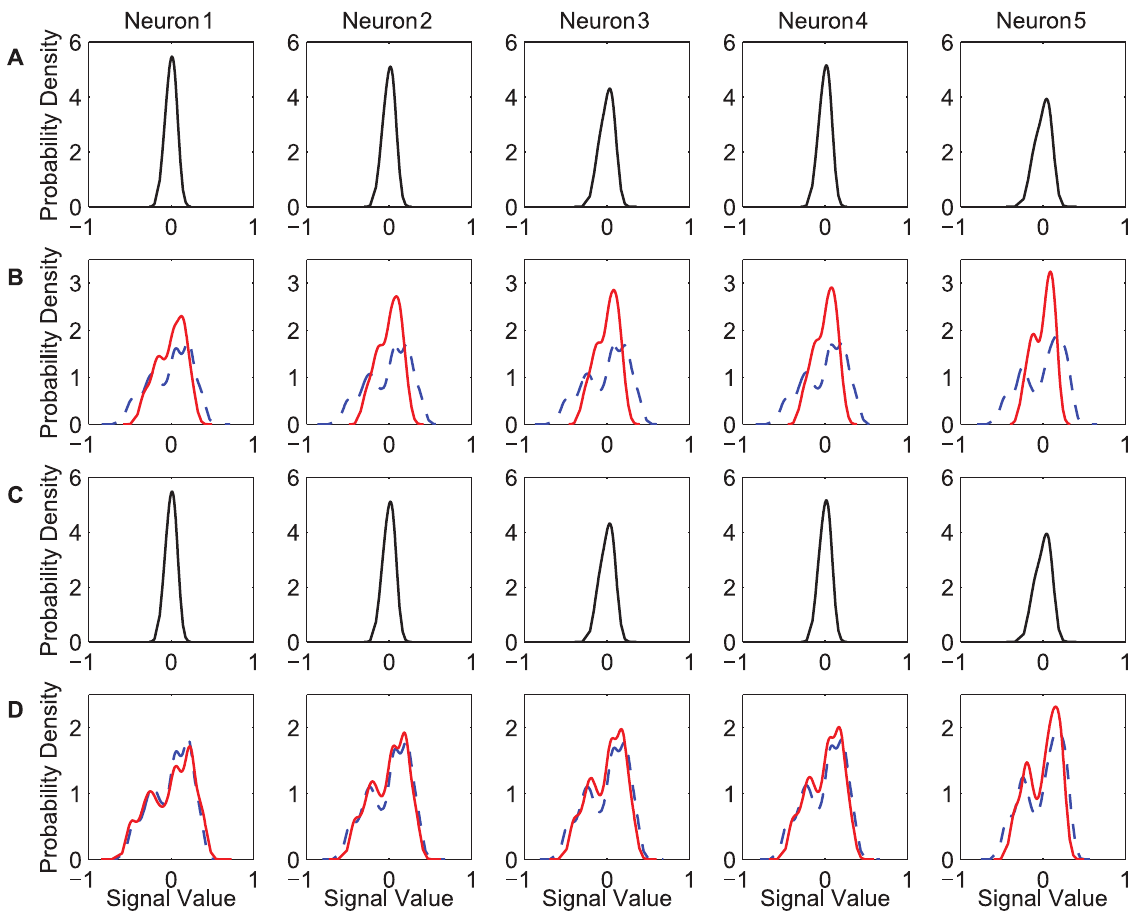
Figure 6. Input and output distributions for neurons in the hidden layer of the FNN. Input and output distributions for the five hidden neurons with the training data set ‘‘MG’’ are displayed. (A) Initial input distributions for the five hidden neurons. (B) Input distributions after 1000- epoch training for the two algorithms. (C) Initial output distributions for the five hidden neurons. (D) Output distributions after 1000-epoch training for the two algorithms. In (B) and (D), the dash lines denote the distributions obtained by the MEE algorithm, and the solid lines denote the distributions obtained by the synergistic algorithm.